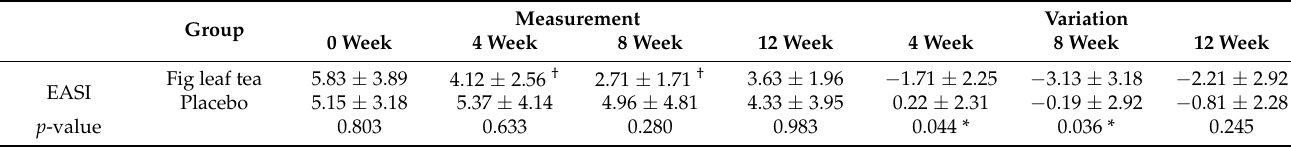
Table 3. Transition of EASI